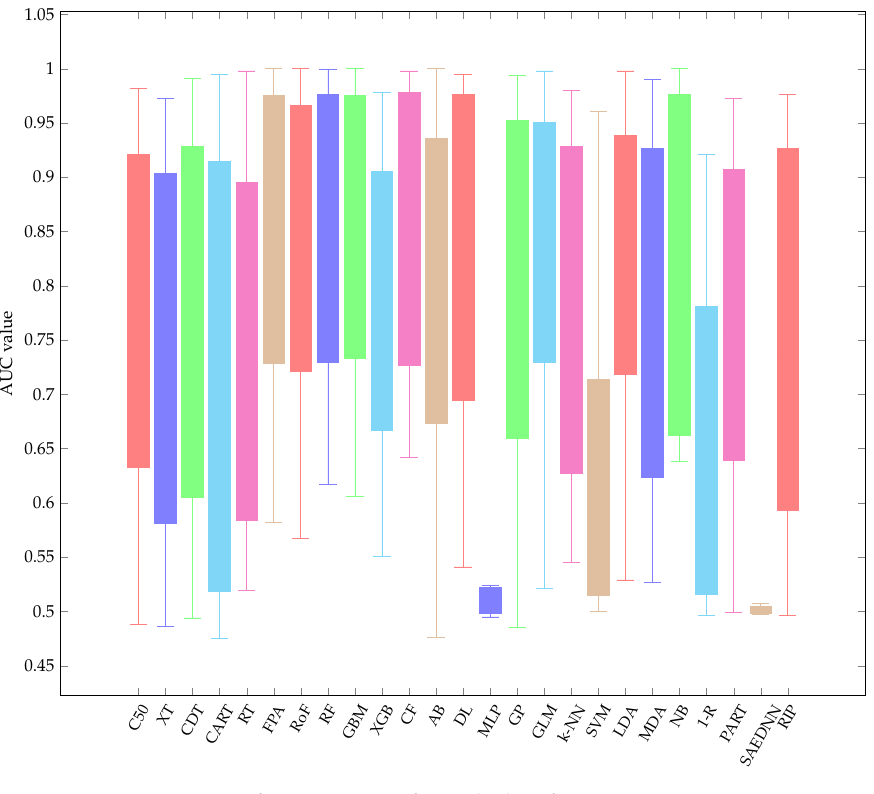
Figure 3. Performance AUC for each classifier w.r.t mean 10cv.